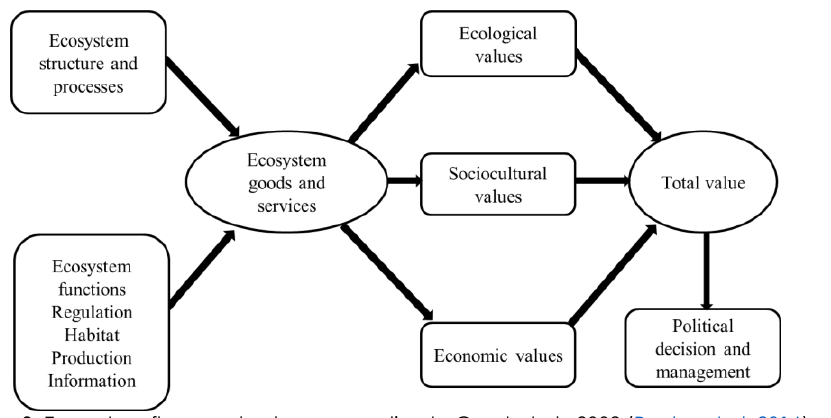
Fig. 3. Ecosystem flows and values, according to Groot et al., 2002 (Roche et al, 2016)